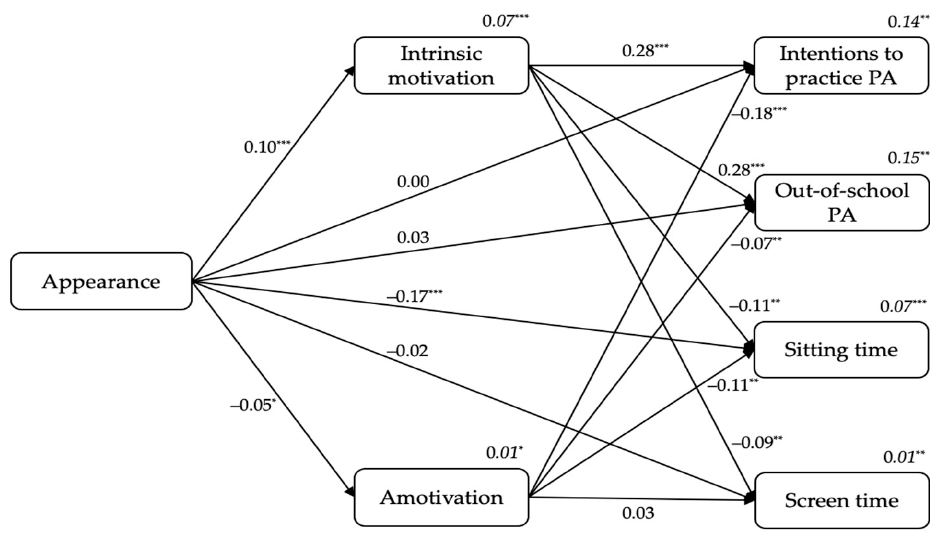
Figure 2. The standardized coefficients from students’ appearance to intrinsic motivation and amotivation, and to outcomes. Note . * p < 0.05. ** p < 0.01. *** p < 0.001. intrinsic motivation ( β = 0.25, p < 0.001), intentions to practice PA ( β = 0.09, p < 0.001),